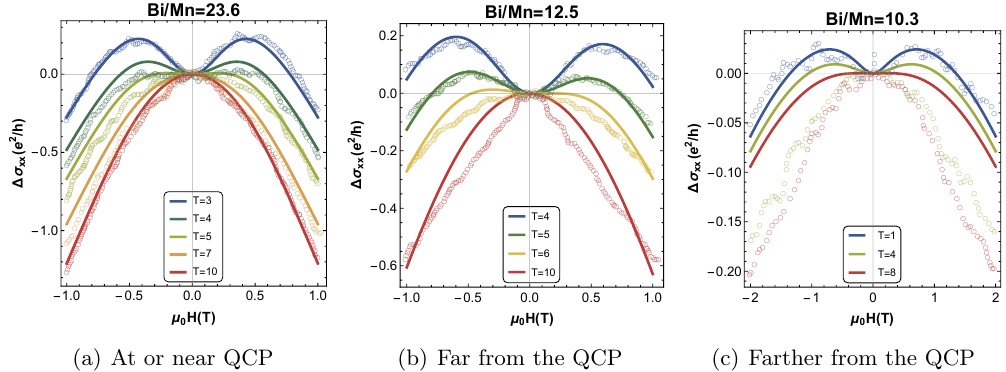
Figure 5 . QCP appears only at special dopings depending on the base material, where the data can be described by our